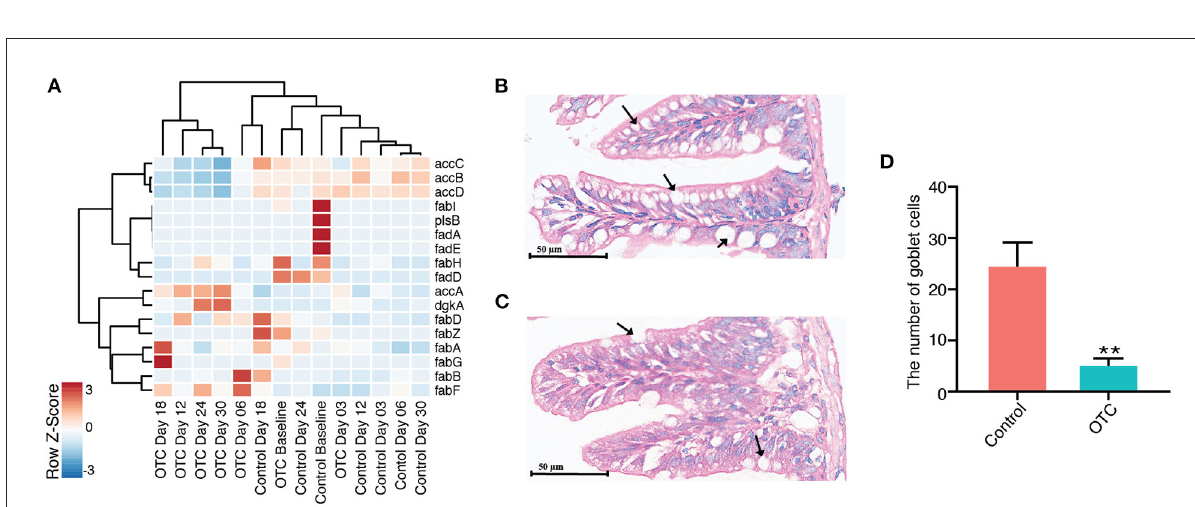
FIGURE6 Impact of OTC exposure on microbial phospholipid metabolism and zebrafish intestinal goblet cells. (A) Heatmap showing the relative abundance of major genes involved in phospholipid synthesis or degradation. Majority of the genes involved in phospholipid synthesis (e.g., accB , accC , accD , and fabI ) were highly abundant in control whereas we observed decreased abundance of these genes after OTC exposure. Furthermore, no major differences were observed in the relative abundance of phospholipid degrading genes (e.g., fadA, fadB, fadD, fadE, and fadL ) in control and OTC exposure groups. (B–D) Histological examinations in zebrafish gut following exposure to OTC for 30 d (200 × magnification, scale bars 50 µ m). (B) Control group, (C) OTC exposure group and (D) The number of goblet cells (as indicated by the black arrows) in zebrafish gut ( n = 5). The data presented are the mean ± SEM of triplicates. Significant differences between OTC groups and the corresponding control group are indicated by * P < 0.05, ** P <